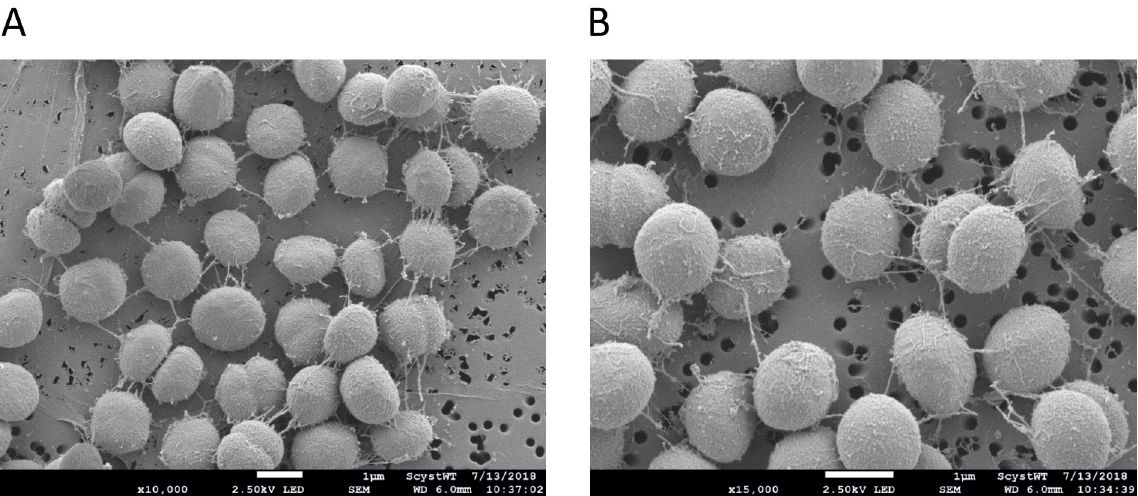
Fig 1. SEM image of Synechocystis cells grown on Millipore Isopore Membrane Filter after 7 days of incubation. (A) pili formation at 10000X magnification, (B) pili formation at 15000X magnification (Bar is 1 μ m in each panel).